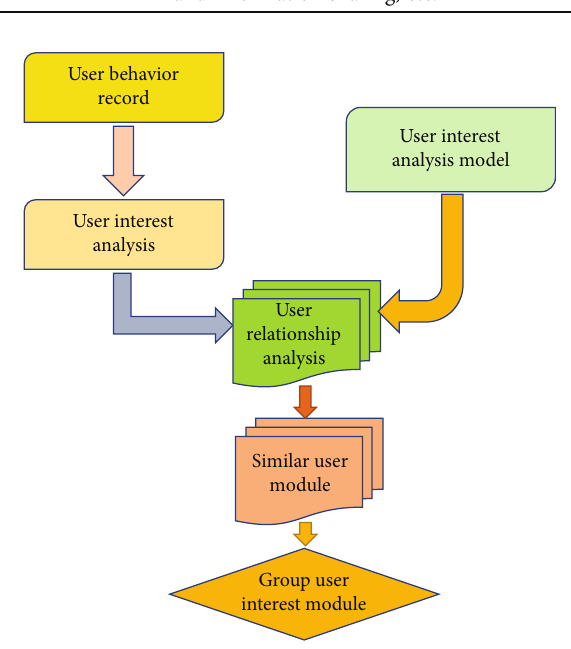
Figure 4: Group modeling of the same interest